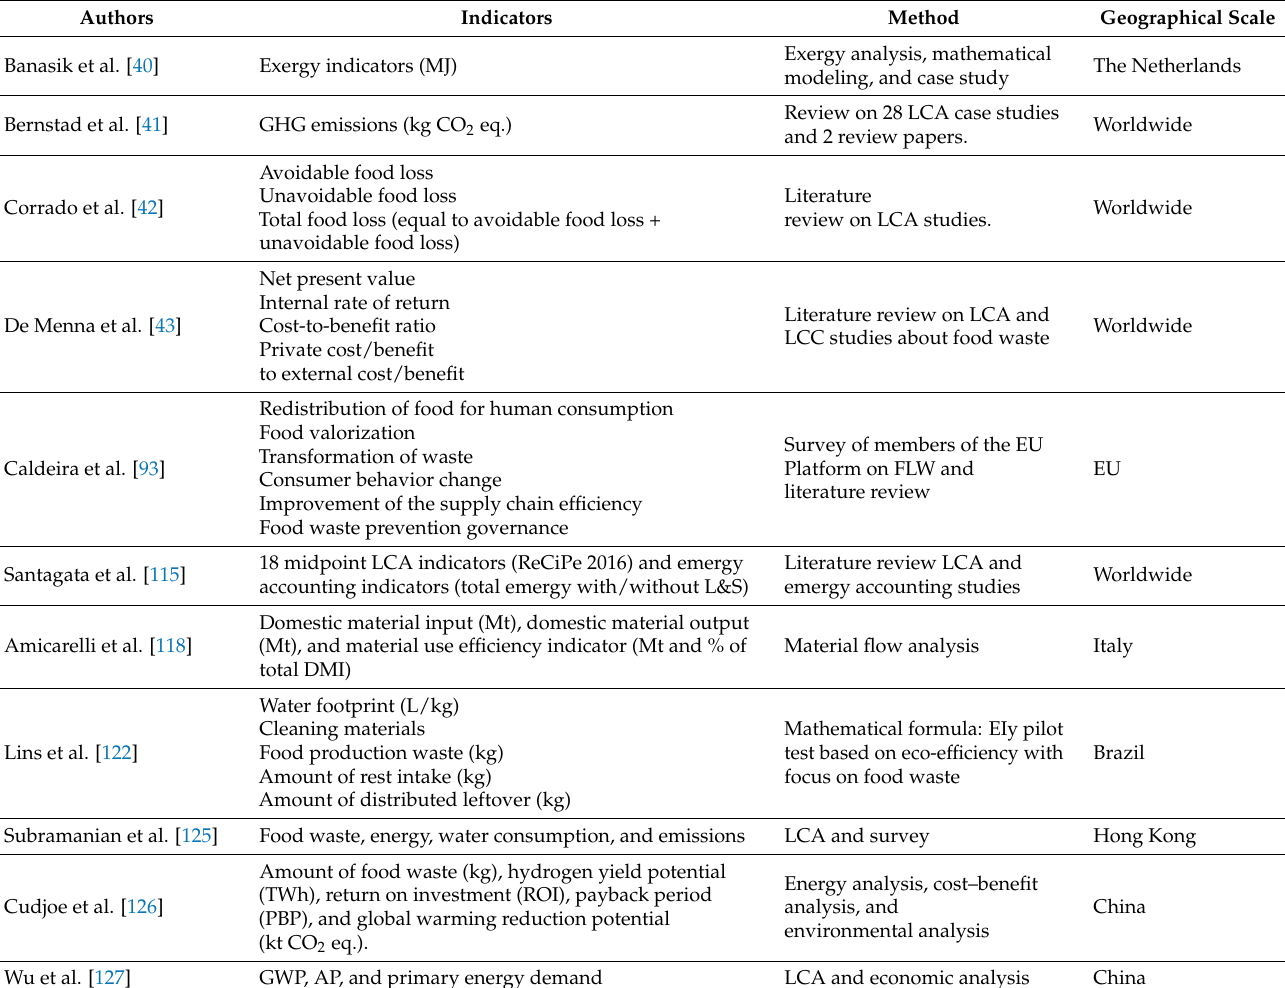
Table 6. Environmental Indicators identified from the reviewed